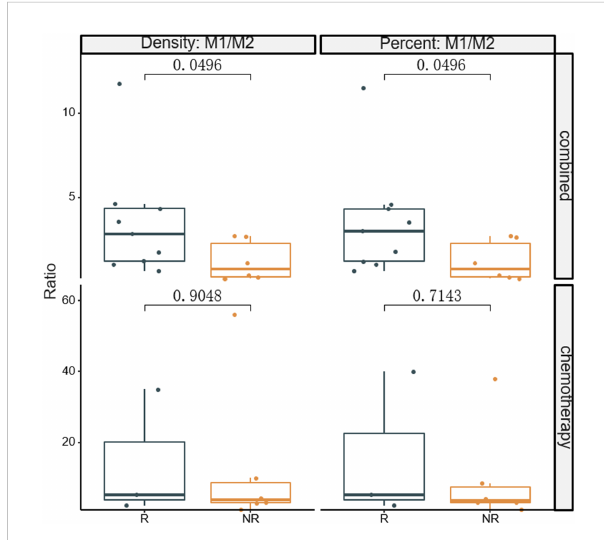
FIGURE 4 Comparison of densities and percentages of M1/M2 ratio in the tumor zone between responders and non-responders. The signi fi cance level of M1/M2 from baseline between the two groups were compared. R, responder; nR, non-responder; Combined, immunochemotherapy; D, density; S, stroma region; M1, CD68 +CD163- macrophage; M2, CD68+CD163+ macrophage; P < 0.05, Signi fi cant